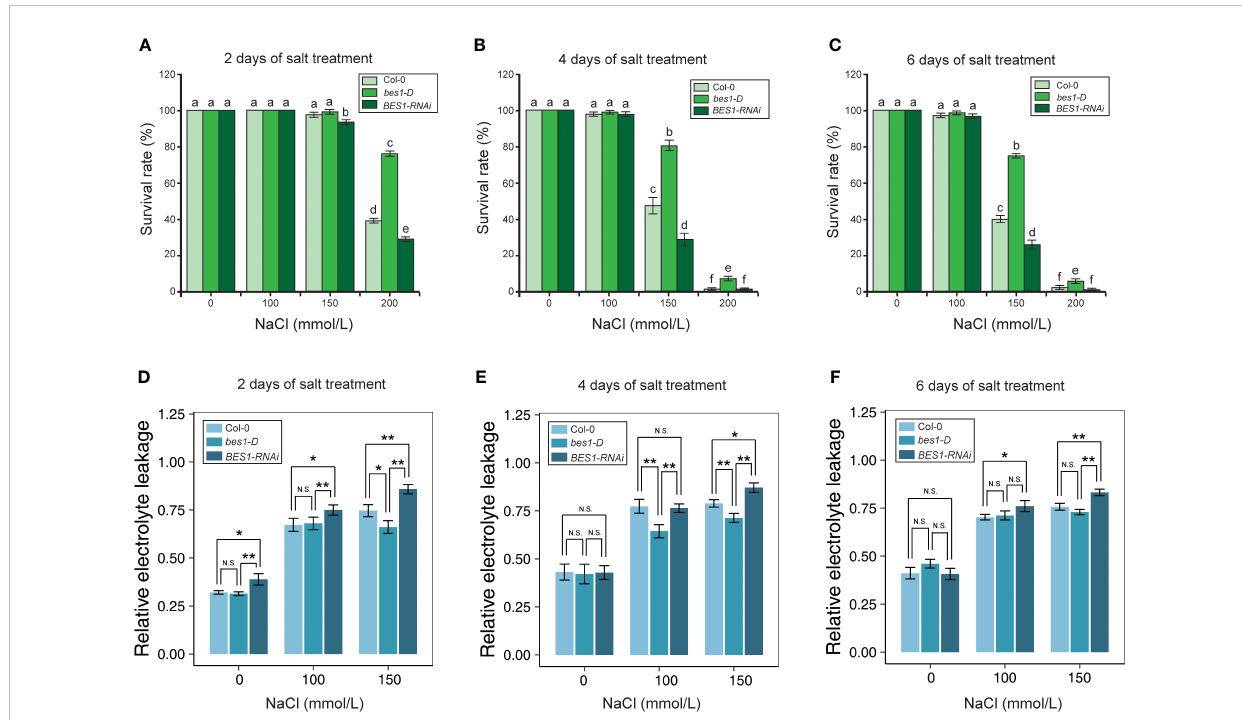
FIGURE 2 Physiological analysis of Col-0, bes1-D , and BES1-RNAi under salt stress. (A – C) Survival rates of Arabidopsis at the 2nd (A) , 4th (B) and 6th (C) day of salt treatment. Five biological replicates were performed. For each replicate, 50 seedlings were planted. Values are means ( ± SE) of fi ve replicates. Statistically signi fi cant differences ( P < 0.05) were calculated by using one-way ANOVA with LSD post-hoc analysis. (D – F) Relative electrolyte leakage of Arabidopsis in 2nd (D) , 4th (E) and 6th (F) day of salt treatment. Values are means ( ± SE) of nine replicates ( t test, * P < 0.05, ** P < 0.01, N.S, not signi fi cant.). Different lowercase letters above bars denote signi fi cant differences of change (P <